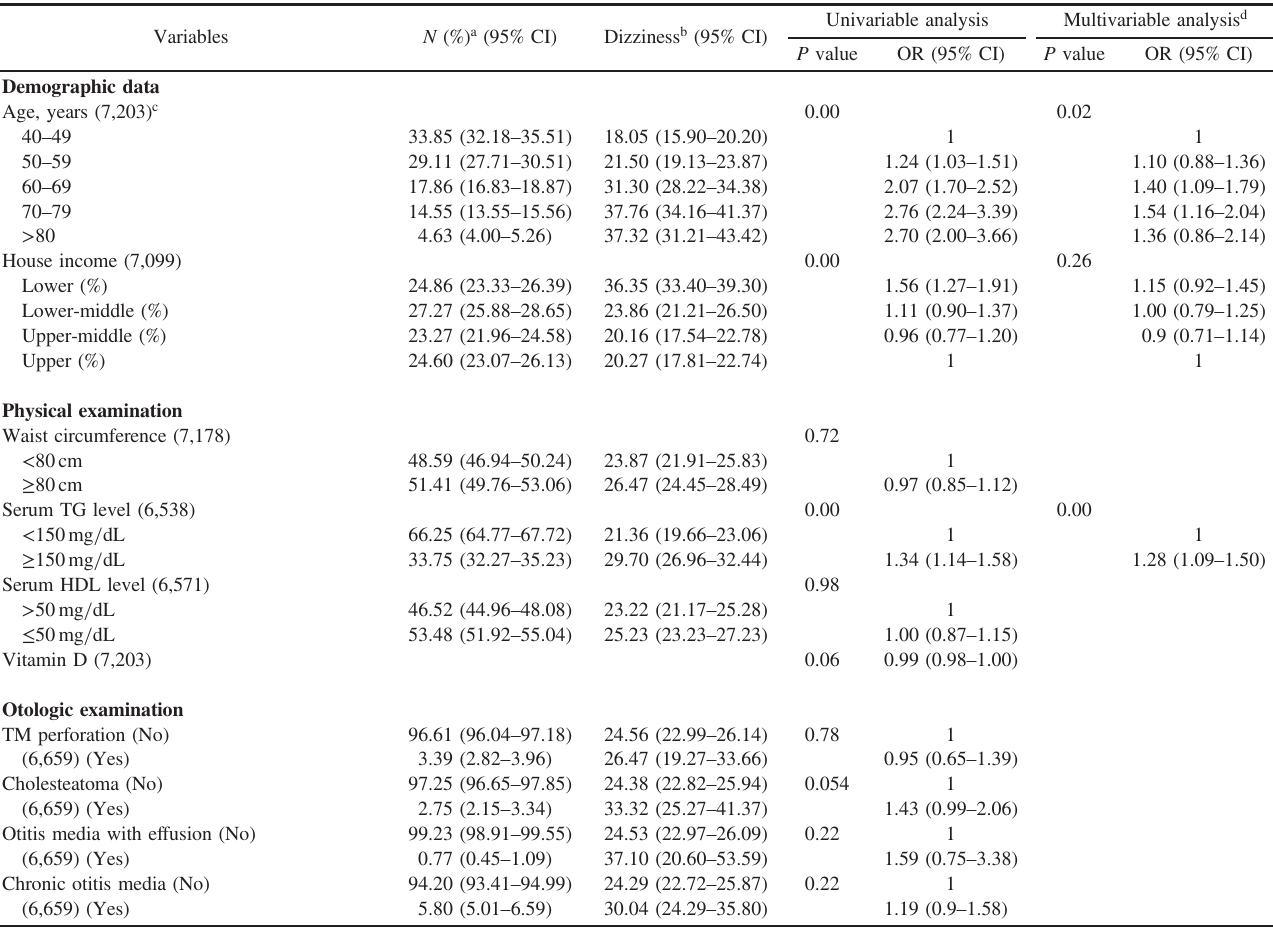
Table 3. Analysis of associated factors in women over 40 years old ( n =